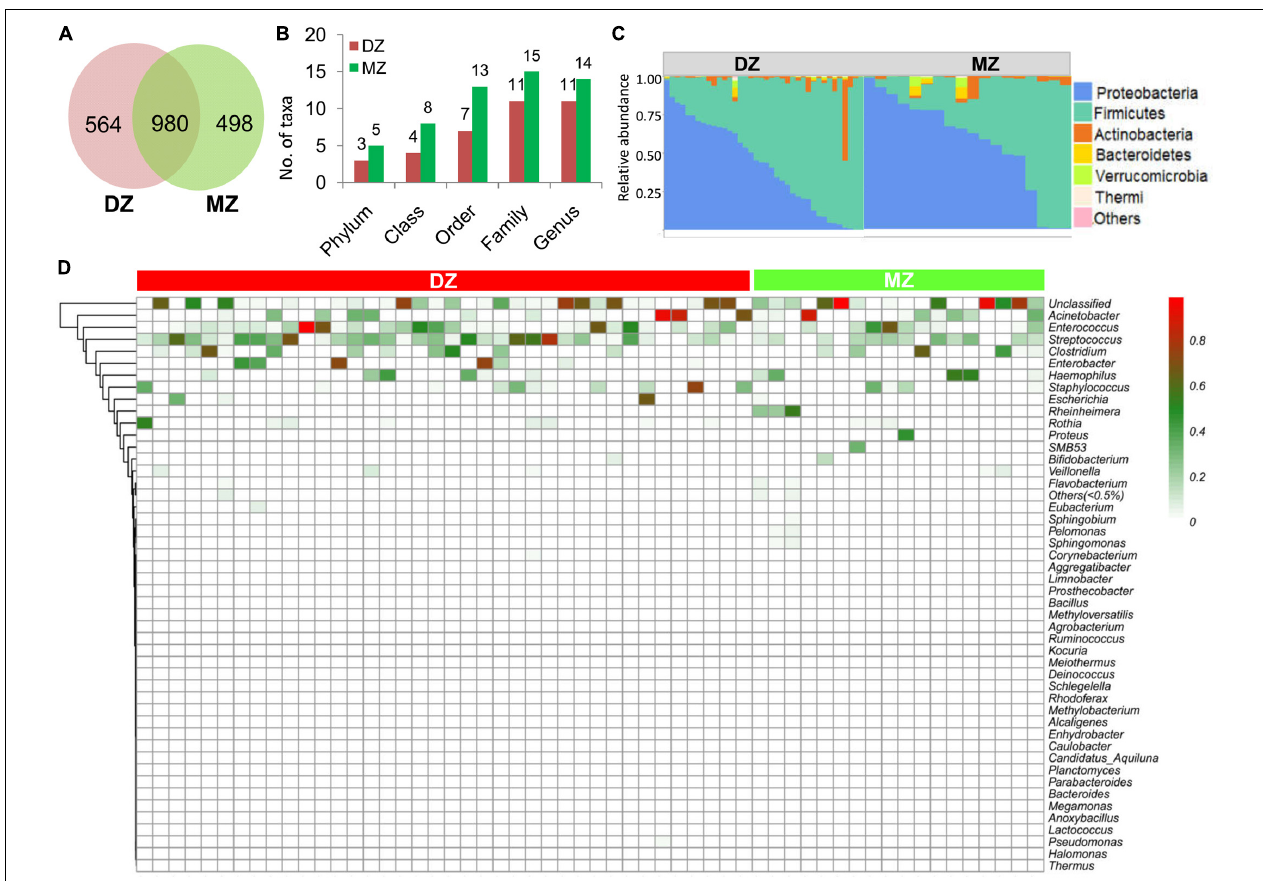
FIGURE 2 | Analysis of OTUs and microbial composition in DZ and MZ. (A) Numbers of unique and shared operational taxonomical units (OTUs) between DZ and MZ. (B) Numbers of phylum, class, order, family, and genus that the OTUs were classified into in DZ and MZ. (C) Relative abundance of bacterial phyla in DZ and MZ. (D) Heatmap showing relative abundances of 48 genera ( > 0.5%) between DZ and MZ. The bar represents the proportion of OTUs affiliated with the